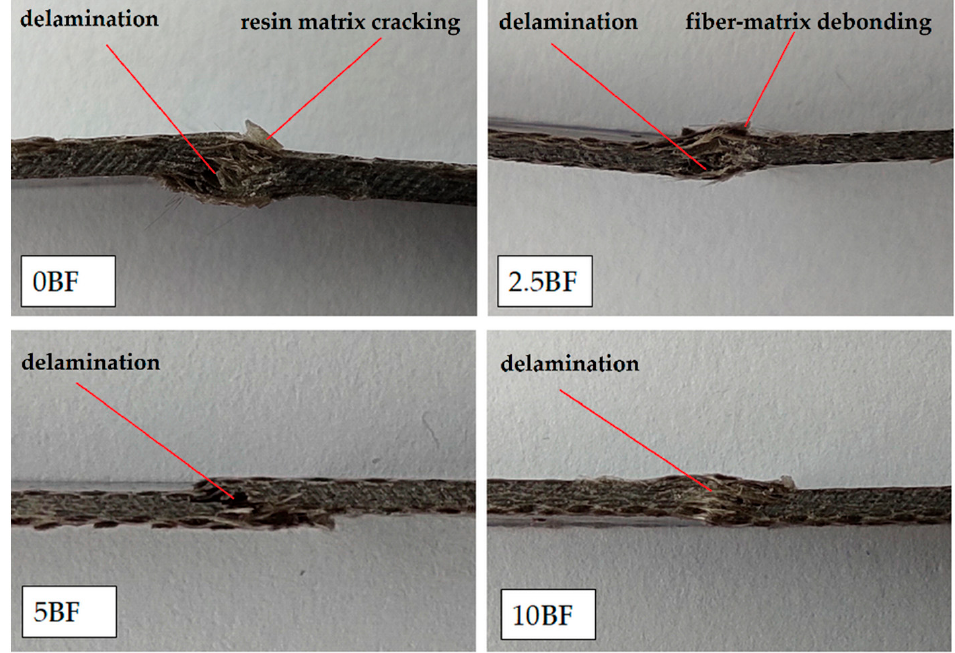
Figure 5. Images of the damaged area of composites modified with basalt micro fiber after the impact test.